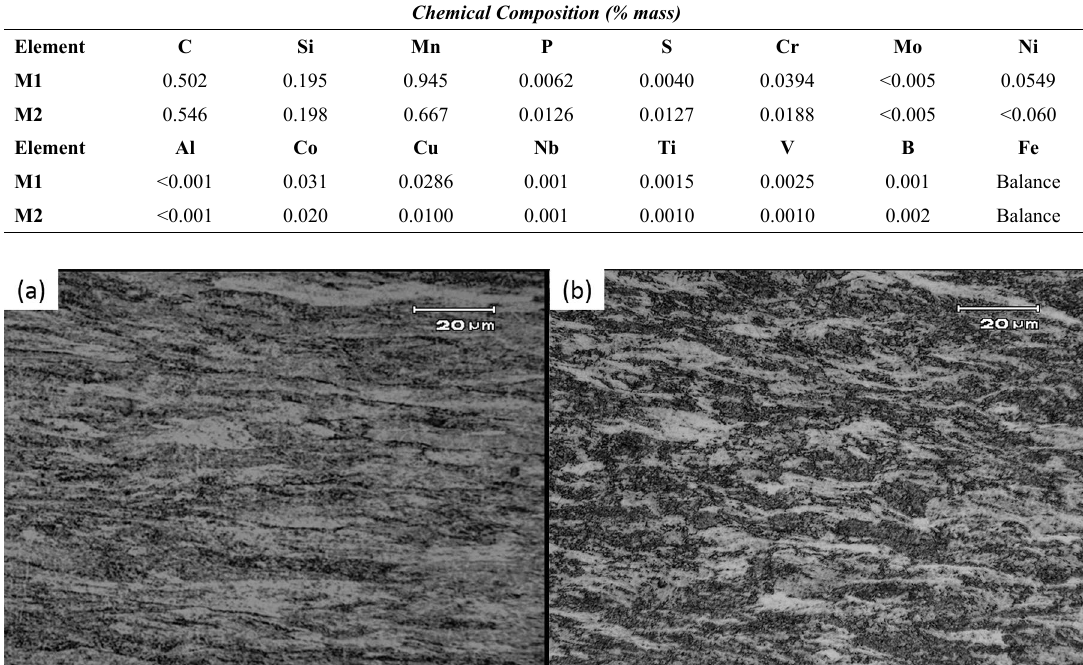
Table 1. Chemical composition of materials under investigation.